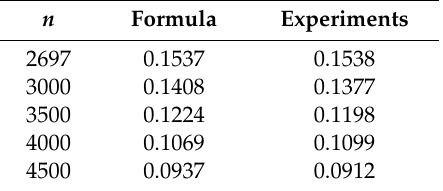
Table 5. Probability that the OOV algorithm will incorrectly estimate a zero bit of the noise vector whose weight is correctly estimated as 78. n Formula Experiments